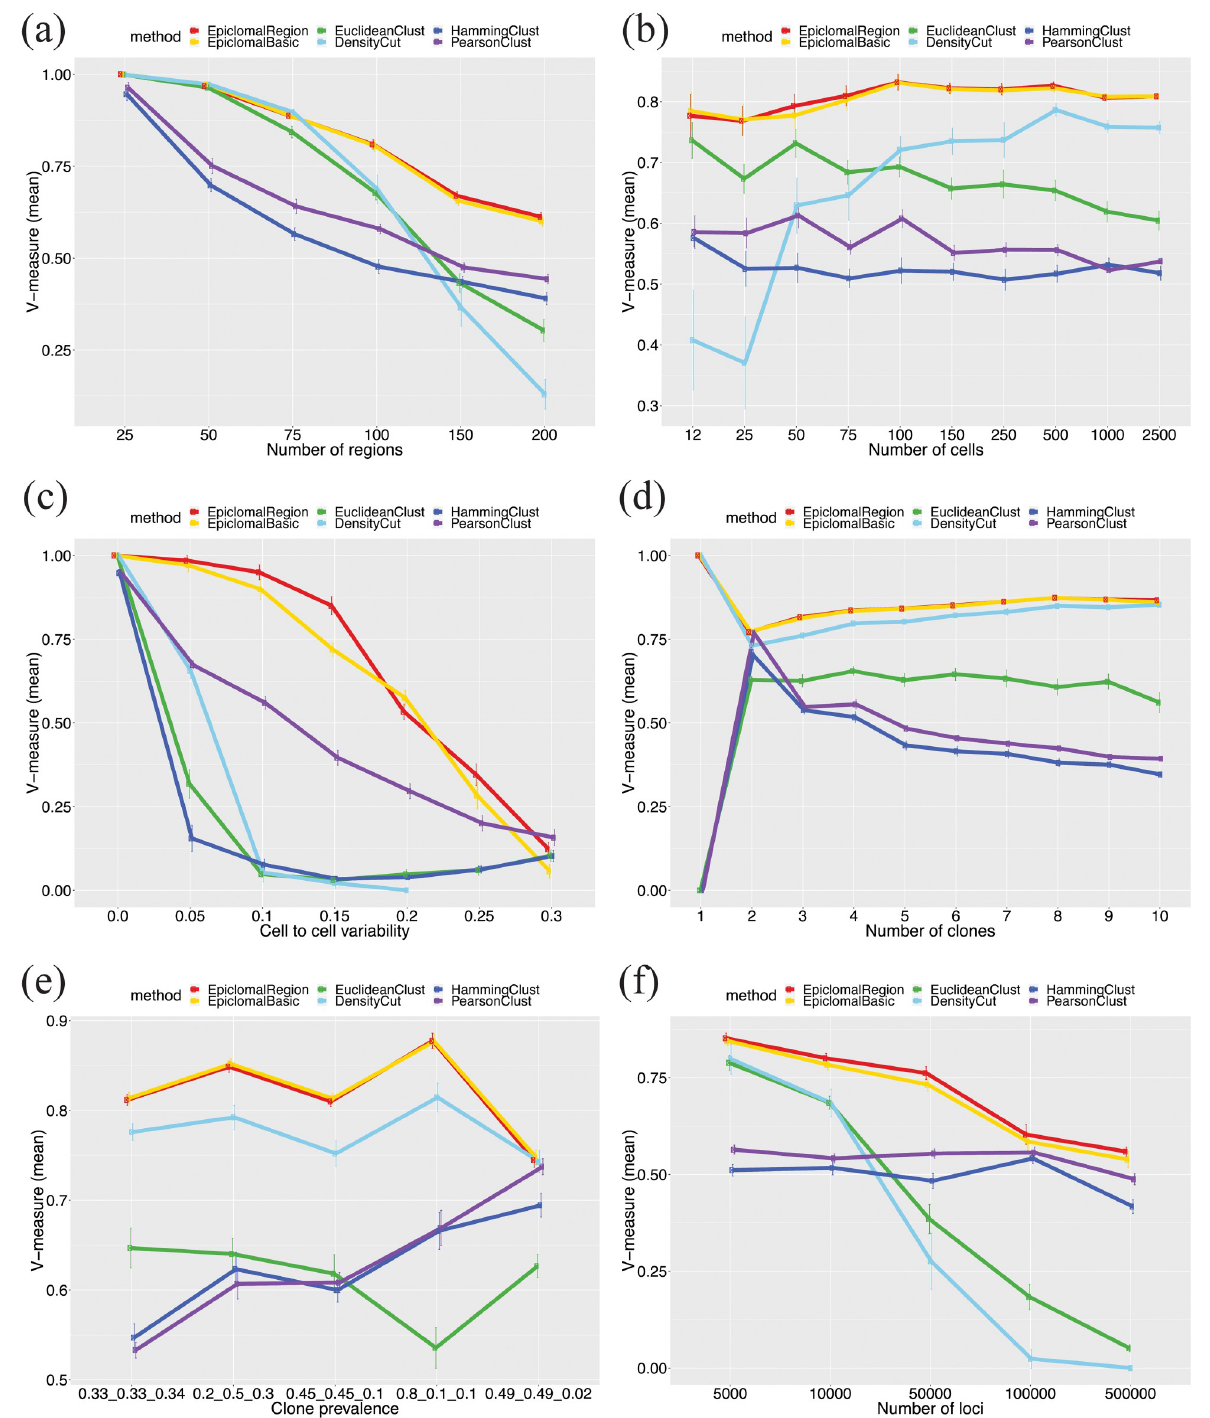
Fig 4. Predicted cell-to-cluster assignments on synthetic data. We report mean V-measures produced by Epiclomal and the non-probabilistic methods taken over 30 randomly generated synthetic data sets, when we vary by: (a) the number of regions, (b) the number of cells, (c) the cell-to- cell variability, (d) the number of clones, (e) the cluster frequencies (prevalences), and (f) the number of loci. The vertical bars correspond to one standard deviation above and below the mean value. The Epiclomal methods outperformed the other methods in all cases.